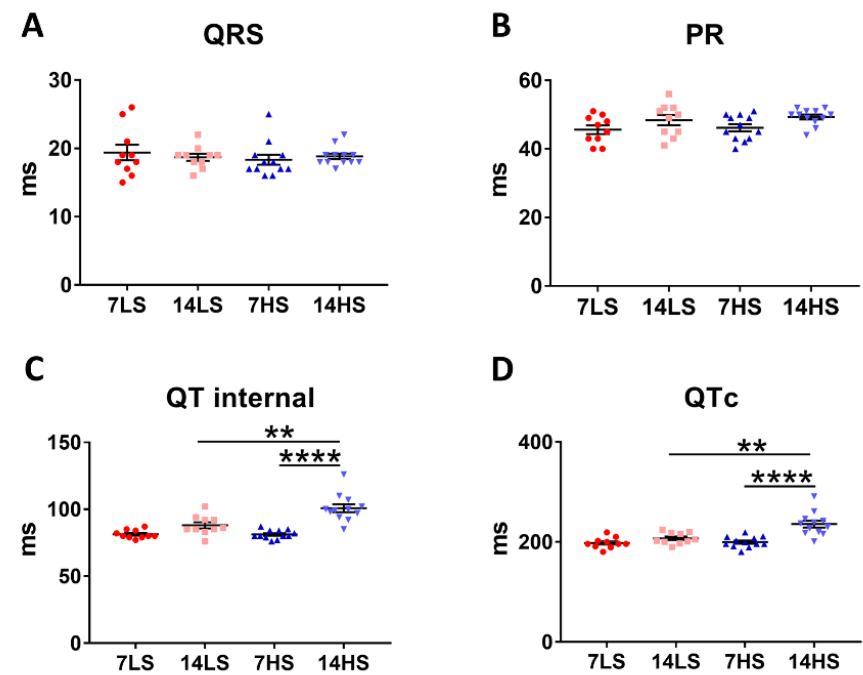
Figure 3. Electrocardiogram analysis showed prolonged myocyte repolarization in HS-fed DSS rat hearts. ( A – D ) QRS width, PR interval, QT interval, and QTc interval in the two groups at the ages of 7 and 14 weeks ( n = 10 in LS group and n = 12 in HS group). ** p < 0.01, **** p < 0.0001.